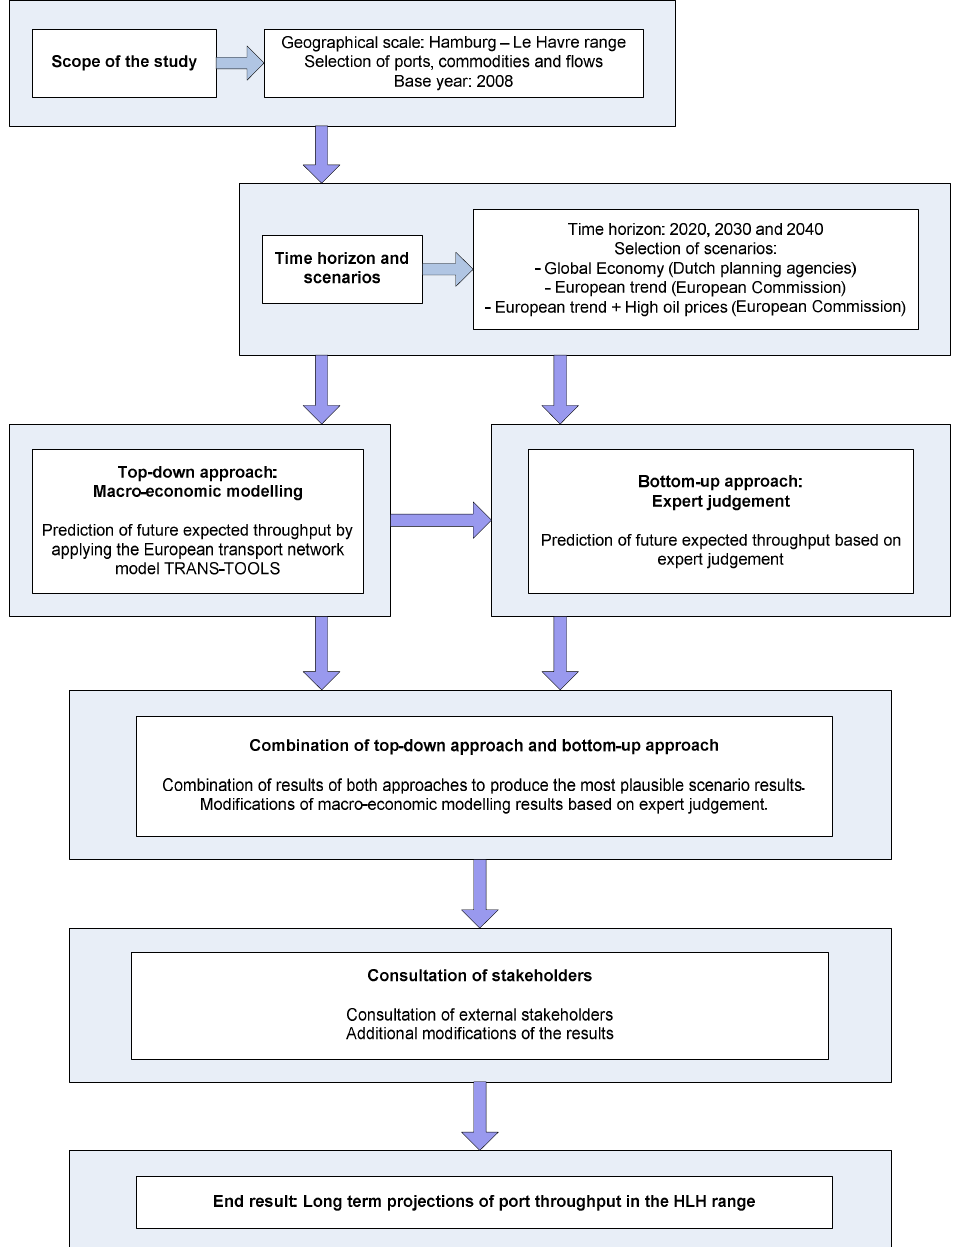
Figure 2. Schematic overview of the